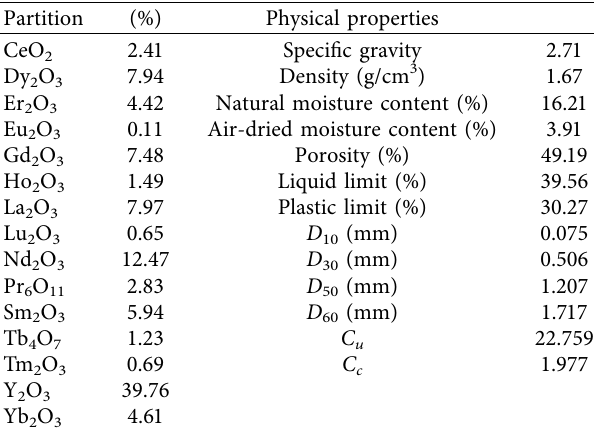
Table 1: Partition and physical properties of ion-adsorption rare earth ore.